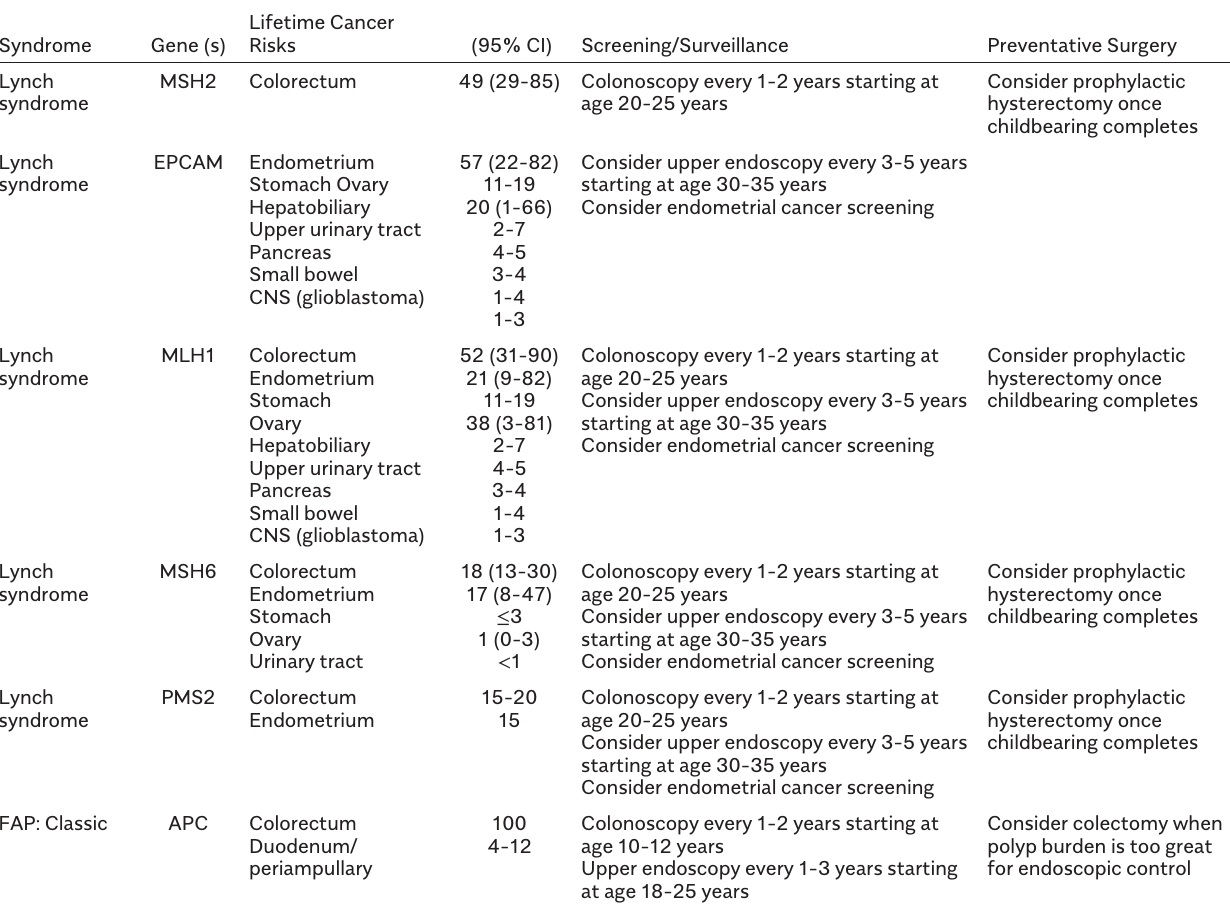
Table 2. Cancer Risks, Genes Associated, and Recommendations for Management of Hereditary CRC Syndromes